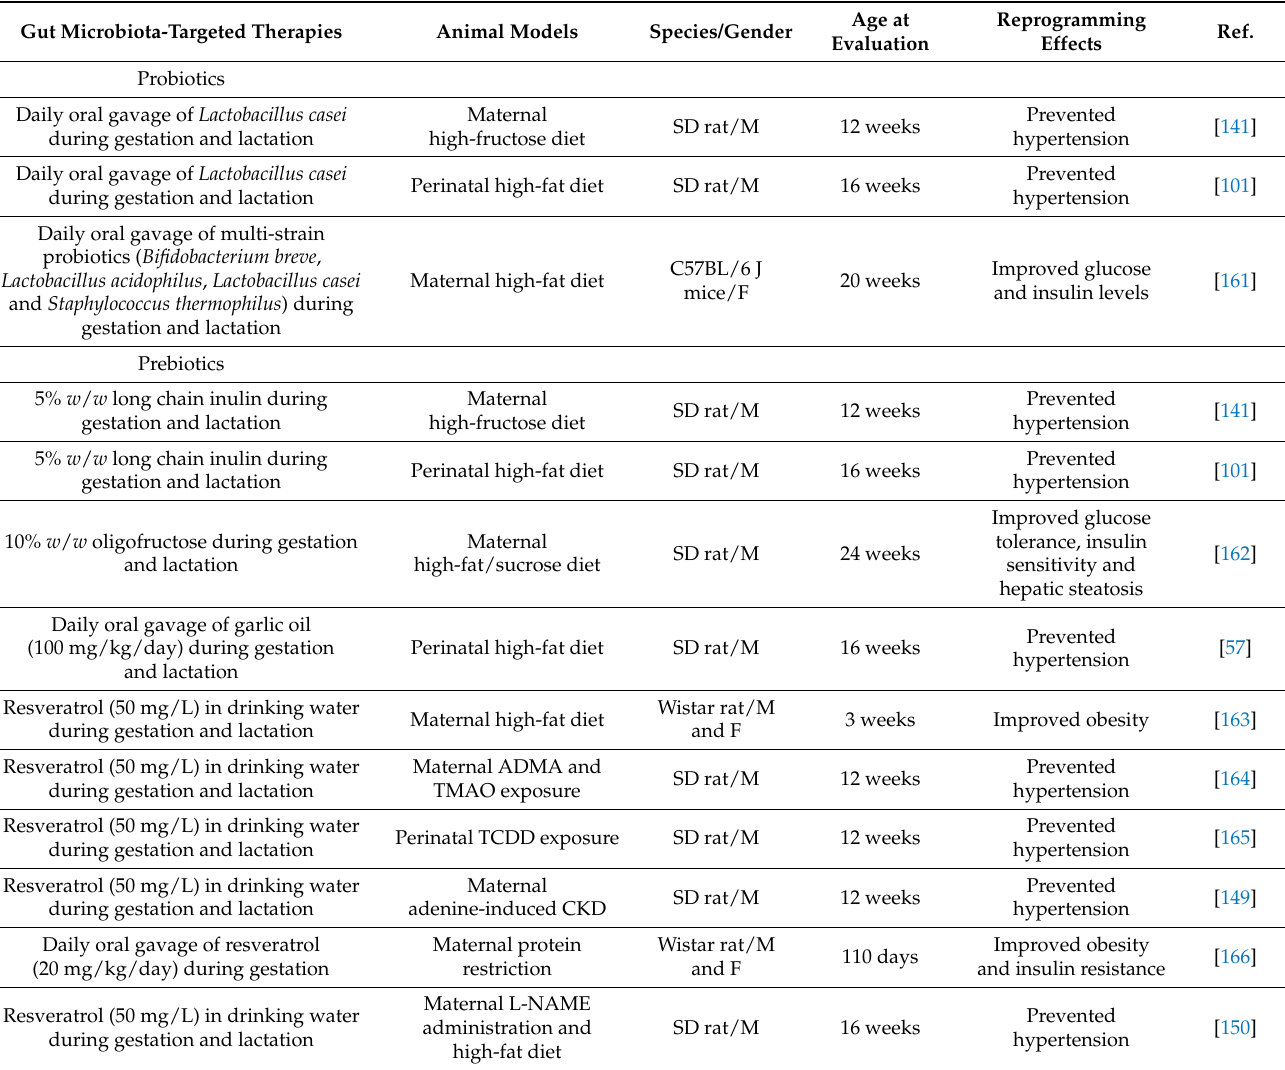
Table 1. Summary of animal models reporting gut microbiota-targeted therapies for MetS of develop- mental